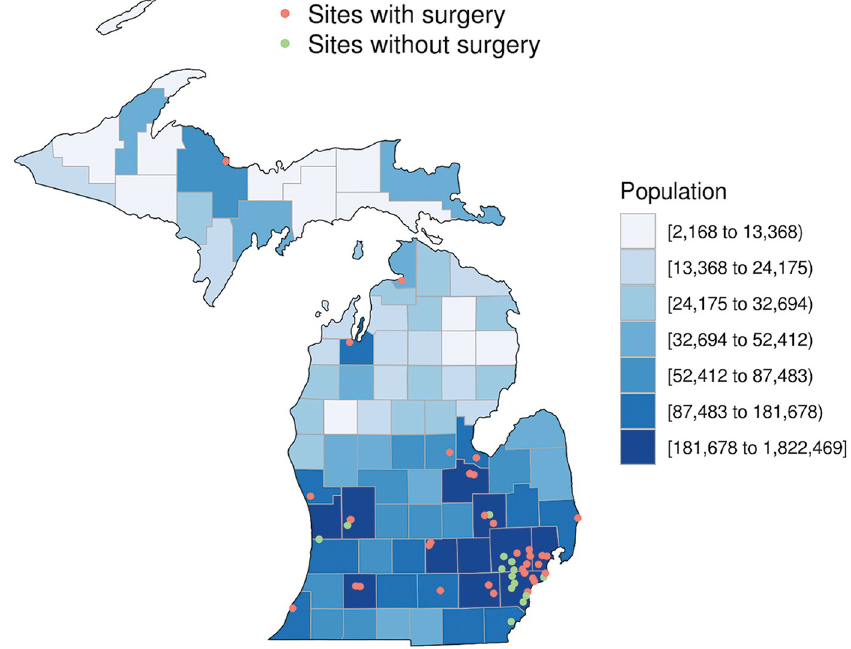
Fig 1. Participating sites in study. Locations of participating PCI capable sites included in this study superimposed on a county-based population density map of the state of Michigan. Data on population density derived from the 2012 United States American Community Survey five-year estimates obtained from the US Census